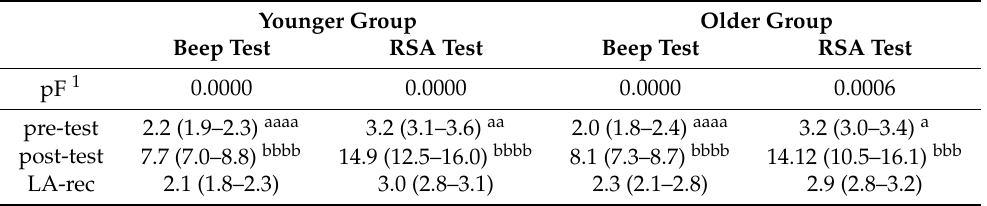
Table 5. The corrected lactate concentration (mmol/L) in the participants’ blood.